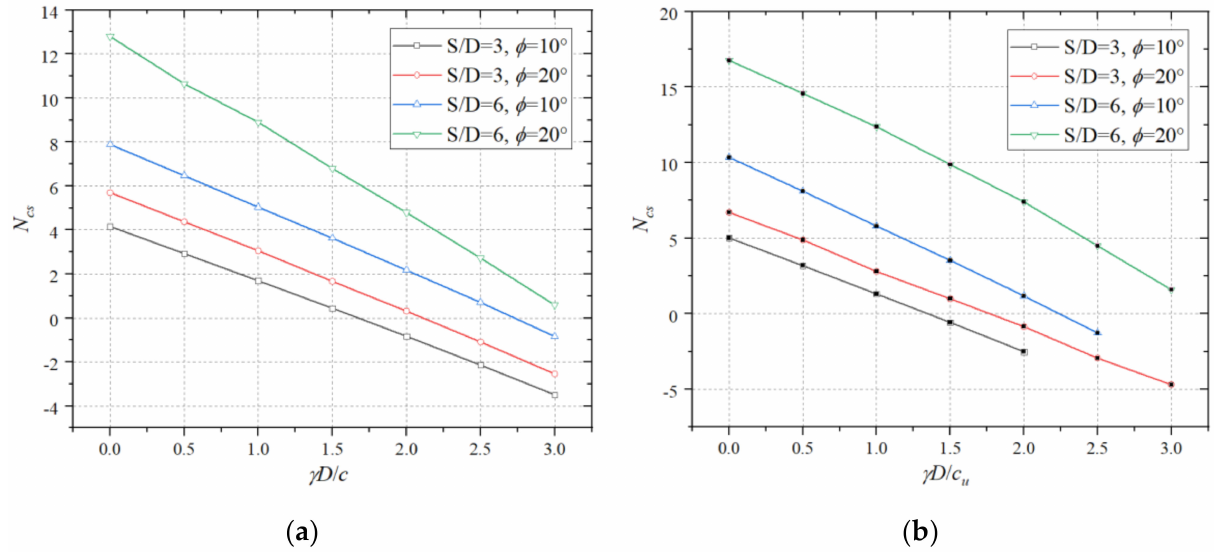
Figure 4. N cs - γ D / c curves with k h = 0.1 and different S / D and ϕ for ( a ) H / D = 2; and ( b ) H / D =